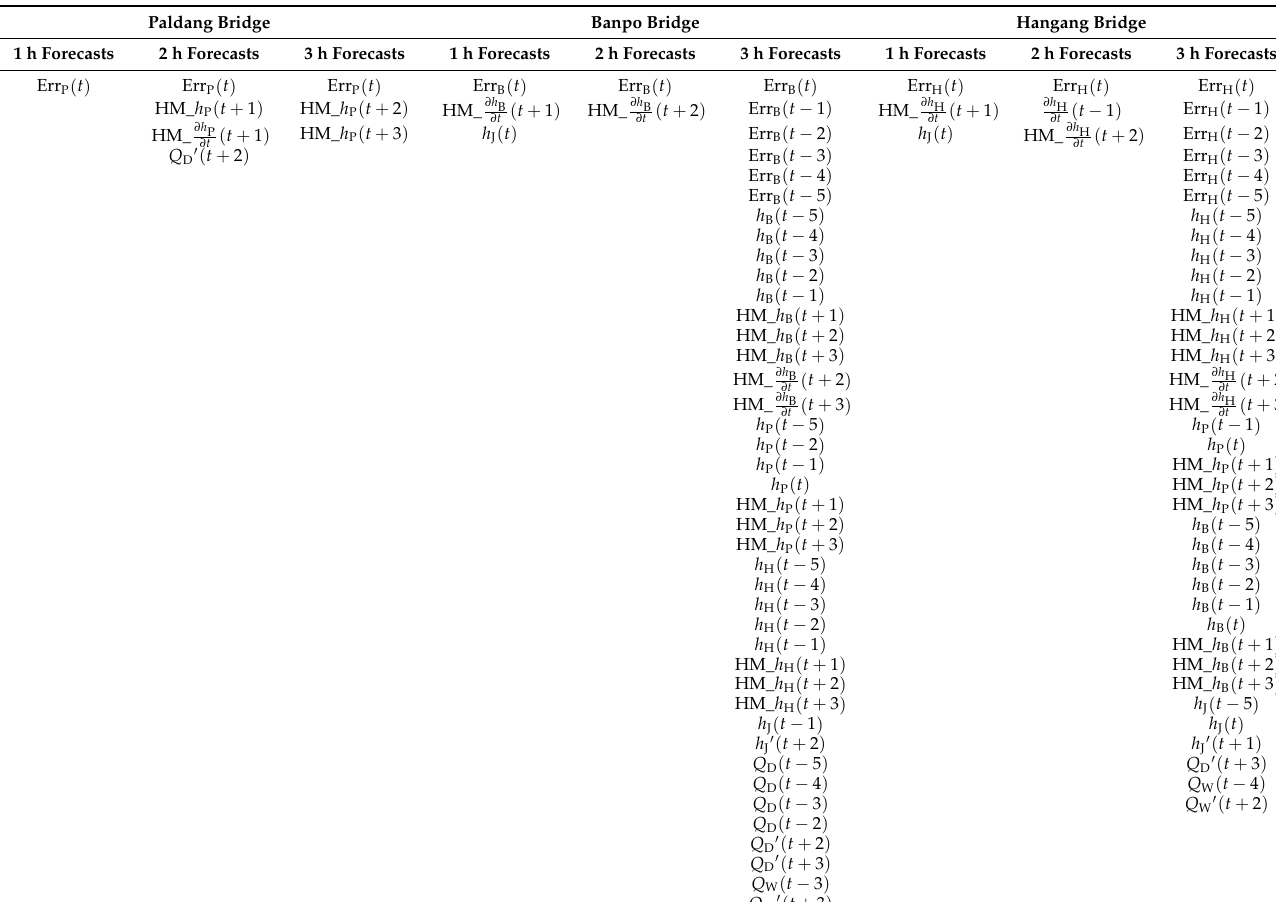
Table 4. Selected input variables for